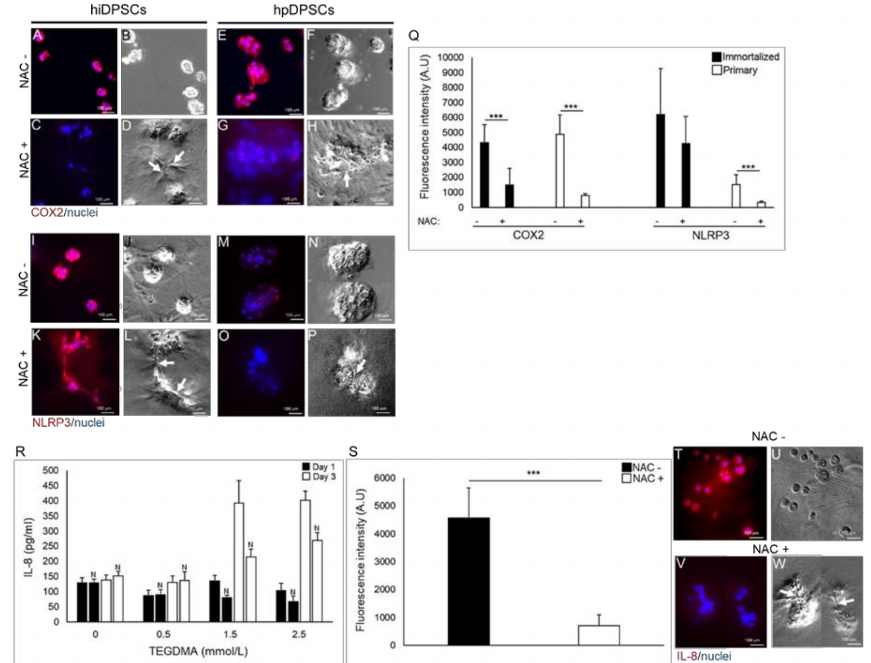
Figure 5. The expression of inflammatory factors in arrested versus rescued pulp microtissues. ( A , C , E , G , I , K , M , O ) Fluorescence stock photos and ( B , D , F , H , J , L , N , P ) phase-contrast images of ( A , B , E , F , I , J , M , N ) growth-arrested spheroids versus ( C , D , G , H , K , L , O , P ) rescued (growth-resumed) pulp microtissues treated with NAC of ( A – D , I – L ) hiDPSCs and ( E – H , M – P ) hpDPSCs expressing ( A – H ) COX2 and ( I – P ) NLRP3. Black arrows point to the interactions between the spherical structures. ( Q ) Bar graph shows the fluorescence intensity of COX2 and NLRP3 in both cell types. *** p ≤ 0.001. ( R ) Bar graph expresses the amount of IL-8 released to the medium from the growth-arrested versus rescued microtissues after 1 d and 3 d. “N” denotes NAC treatment and ( S ) the expression level of IL-8 in the cells after a 14-d incubation. *** p ≤ 0.001. ( T , V ) Fluorescence stock photos and ( U , W ) phase-contrast images of IL-8 expression of samples exposed to a moderate concentration of TEGDMA and ( T , U ) non-treated versus ( V , W ) treated with